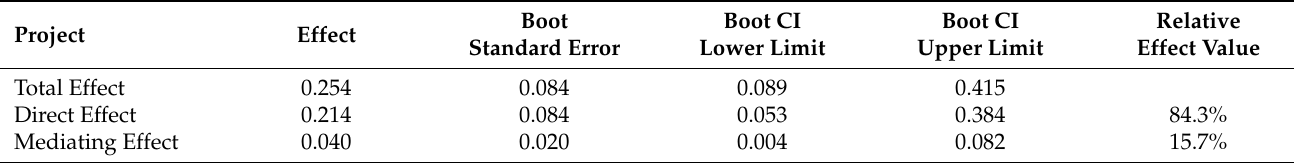
Table 8. Breakdown of total effect, direct effect, and mediating